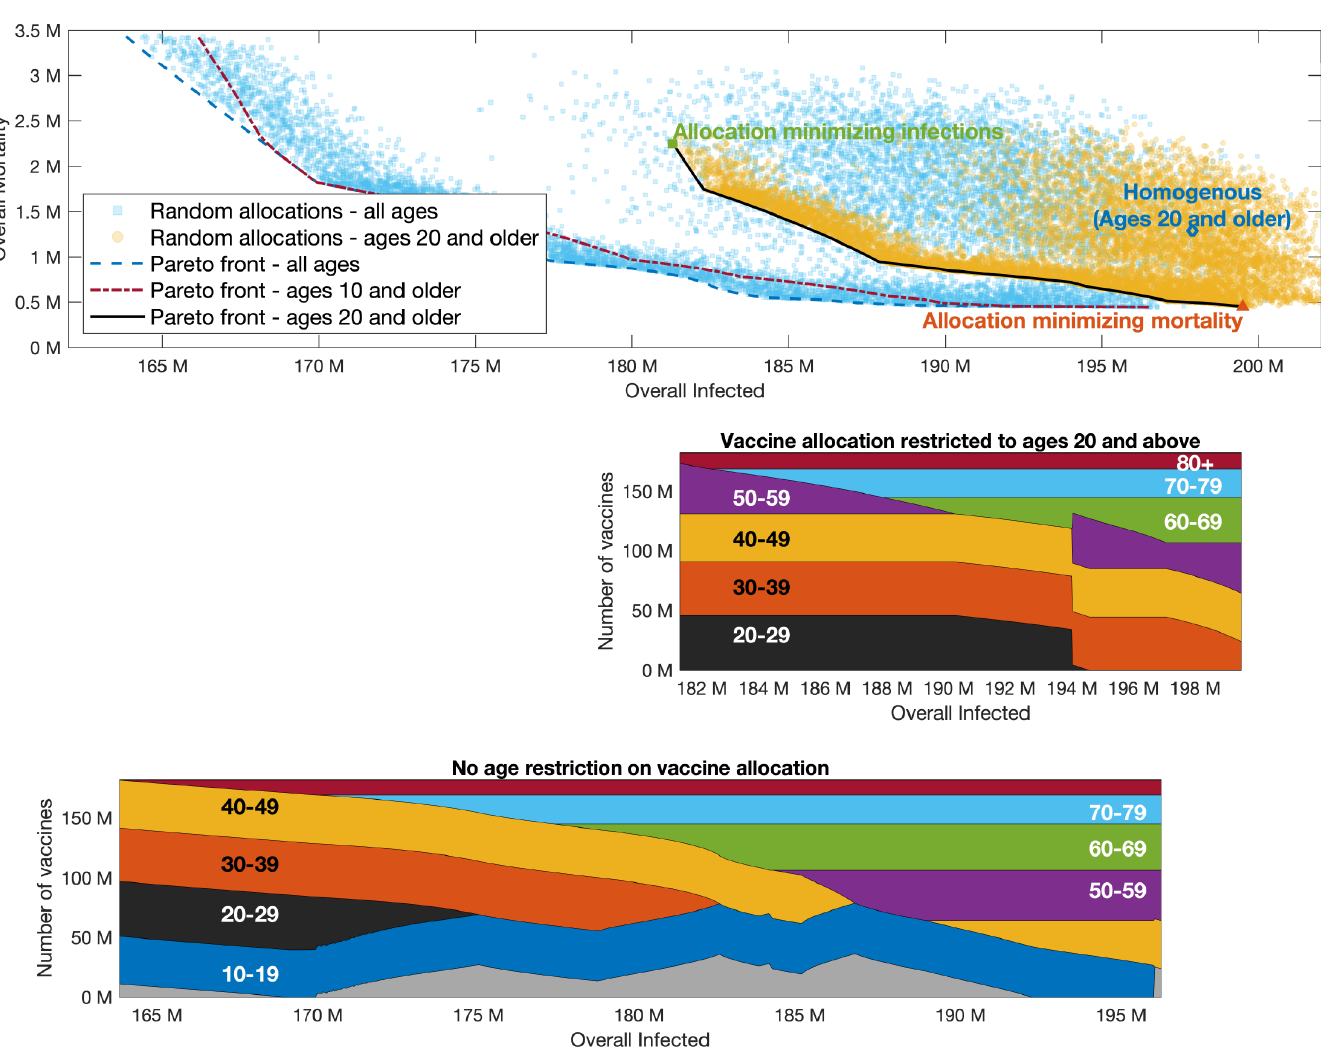
Fig 6. Pareto front. Same as Fig 5 with R 0 =